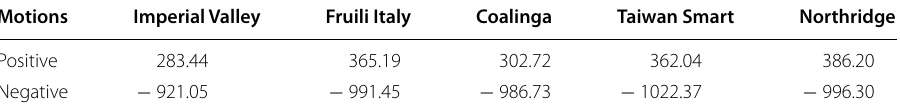
Table 6 Bending moment of the sheet pile under the different earthquake motions (kNm) Motions